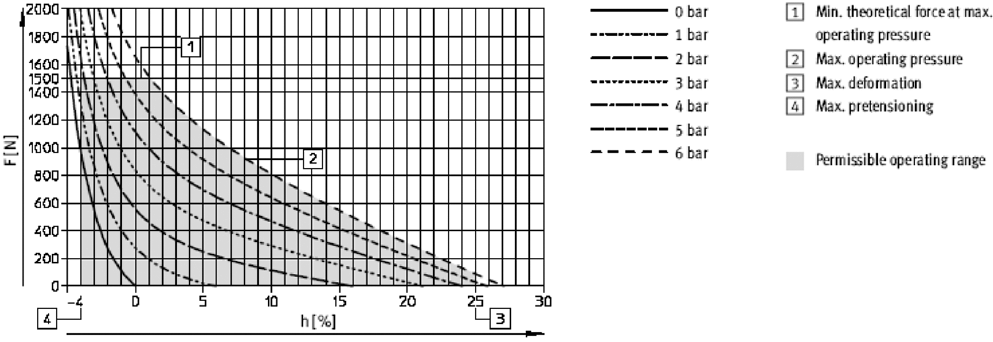
Fig. 2. Pulling force versus contraction of the DMSP20